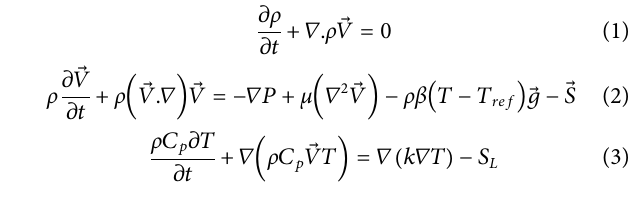
incompressible, transient, and laminar. (cid:129) The direction of gravity acceleration is taken along the negative y -axis. (cid:129) The exterior boundaries are completely insulated, and as a result, the heat losses to the surroundings are neglected. (cid:129) The no velocity-slip boundary condition is considered at the solid boundaries.